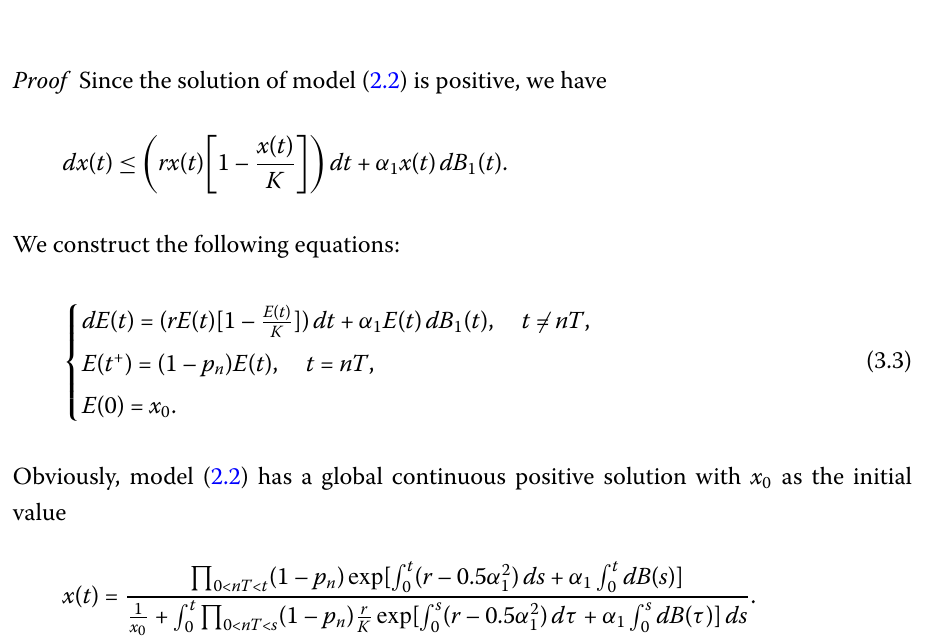
Figure 1 Time series graphs and phase diagrams for model (2.2): The parameter values are fixed as follows: initial value ( x 0 , y 0 ) = (5,3), r = 3, K = 12, β = 0.3, λ = 0.5, η =